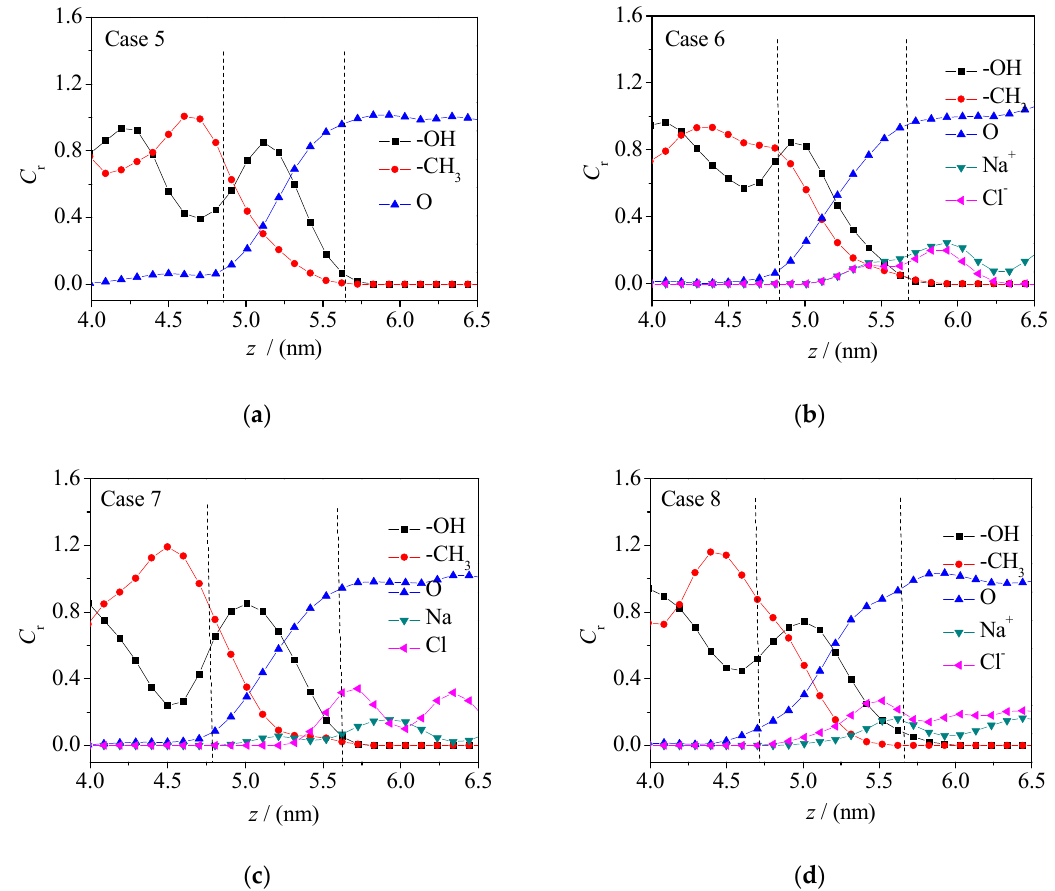
Figure 5. Concentration distribution curve of F, C, O, Na + , and Cl − at the oil–water interface in the 1-pentanol–NaCl aqueous solution system: ( a ) Case 5; ( b ) Case 6; ( c ) Case 7; ( d ) Case 8.